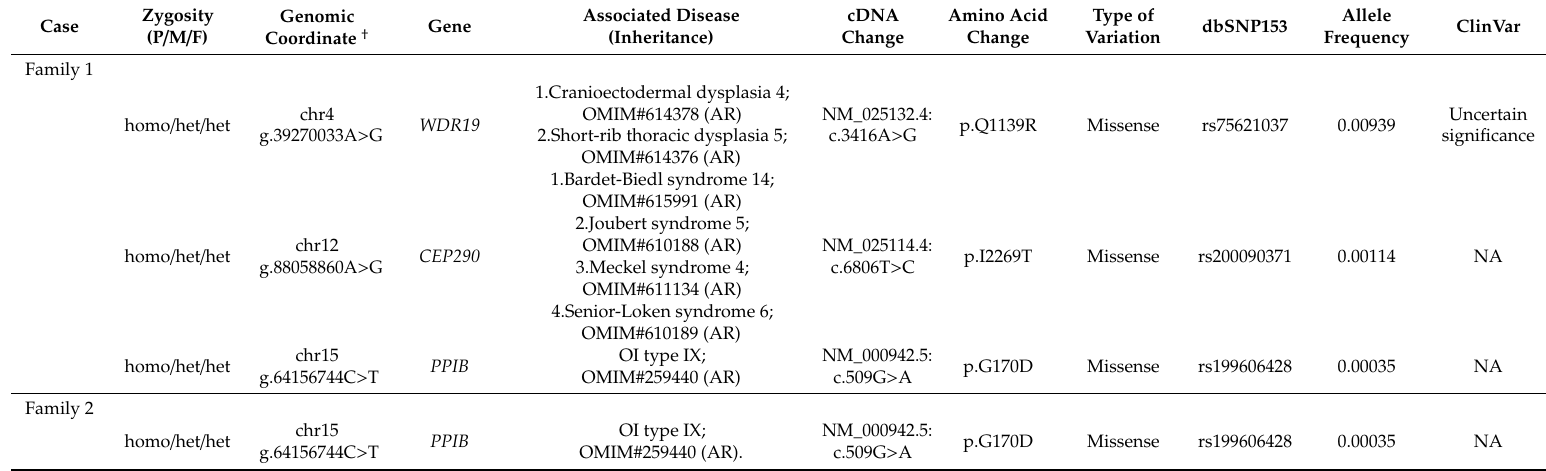
Table 1. Summary of the trio-based whole exome sequencing (trio-WES) results for the two families (Family 1 and Family 2) with fetal skeletal dysplasia (SD).